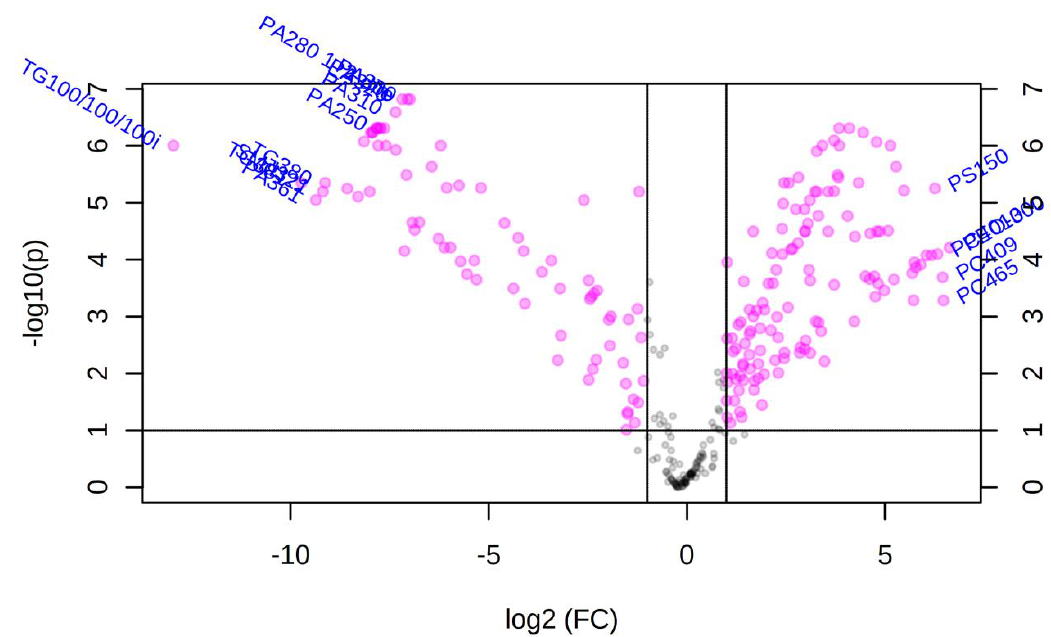
Figure 7. Volcano plot of the untargeted lipidomics analysis of differentially regulated features between the somatic extract of infective third-stage larvae (L3) of N. brasiliensis (NB_SE) and the somatic extract of T. muris eggs (TM_SE). The volcano plot displays log2 fold changes versus Benjamini–Hochberg adjusted p -values (-log10 transformed). Features that exhibited an absolute log 2 fold change > 2 and an absolute p -value < 0.05 are coloured in pink. Most significant features which could be structurally annotated are labelled with the corresponding name. Gray dots represent features that were not significantly altered (having fold change less than 2). The further its position away from the (0,0), the more significant the lipid is.